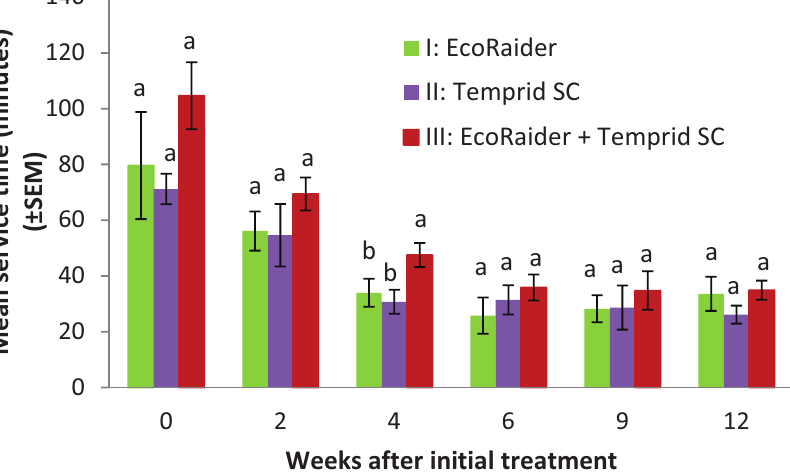
Figure 3. Mean service time per apartment for three different treatments. Means within the same observation period with different letters are statistically different (Fisher’s LSD test, p <